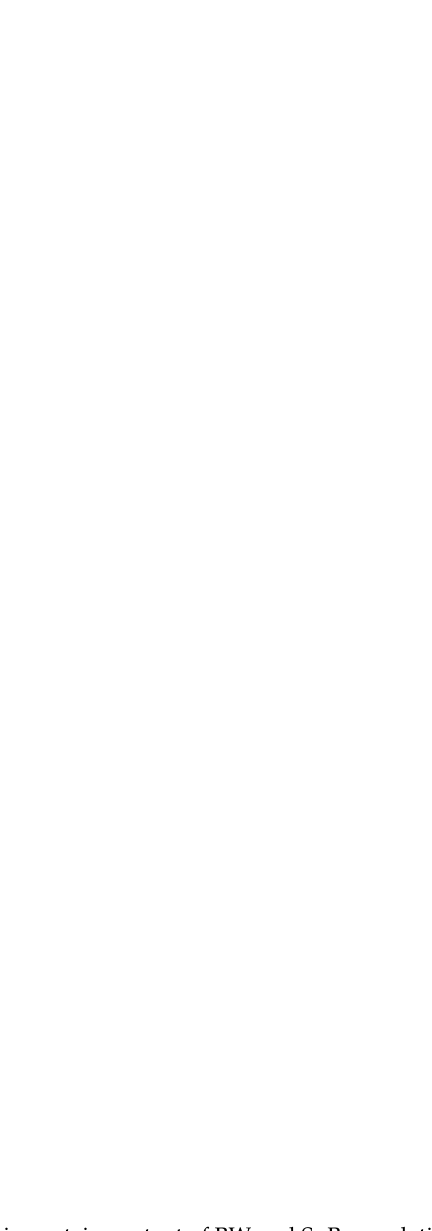
Figure 2. Violin plots of yield-related traits and grain protein content of BW and SpB populations. TGW: thousand grain weight; NUE: nitrogen use